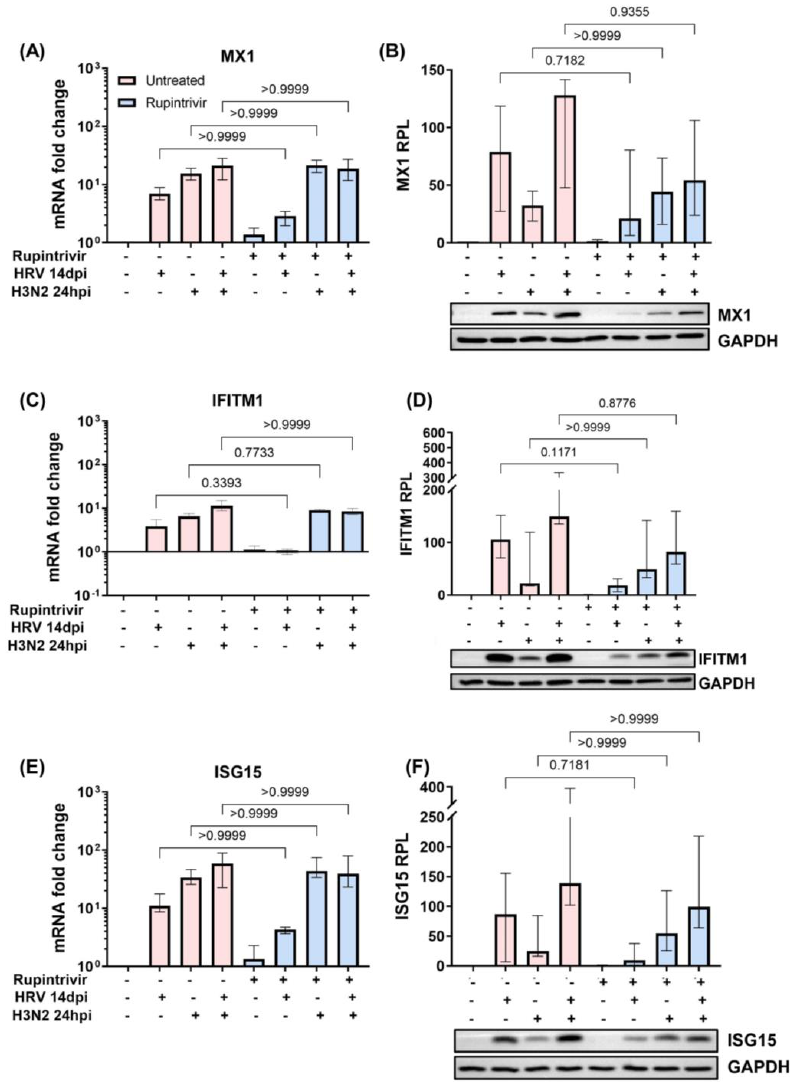
Figure 5. Earlier and longer-duration Rupintrivir inhibition of 3C protease from primary prolonged HRV infection led to decreasing trends in protein levels of ISG proteins MX1, IFITM1, and ISG15 during secondary H3N2 infection. The mRNA fold changes ( n = 4) and relative protein levels (RPL) ( n = 6) of ( A , B ) MX1, ( C , D ) IFITM1, and ( E , F ) ISG15 during secondary H3N2 infection, with and without longer-duration Rupintrivir treatment, in mock and infected hNECs. Representative West- ern blot images are shown. The relevant band intensities were measured using ImageJ software. Protein levels were normalized to the host GAPDH protein. The p -value was calculated by one-way ANOVA and non-parametric, Kruskal–Wallis test. The data are represented as medians with inter- quartile values. 4. Discussion Our previous study found that prolonged HRV infection induces sustained expres- sion of viral components (HRV RNA and protein) and antiviral host factors (particularly